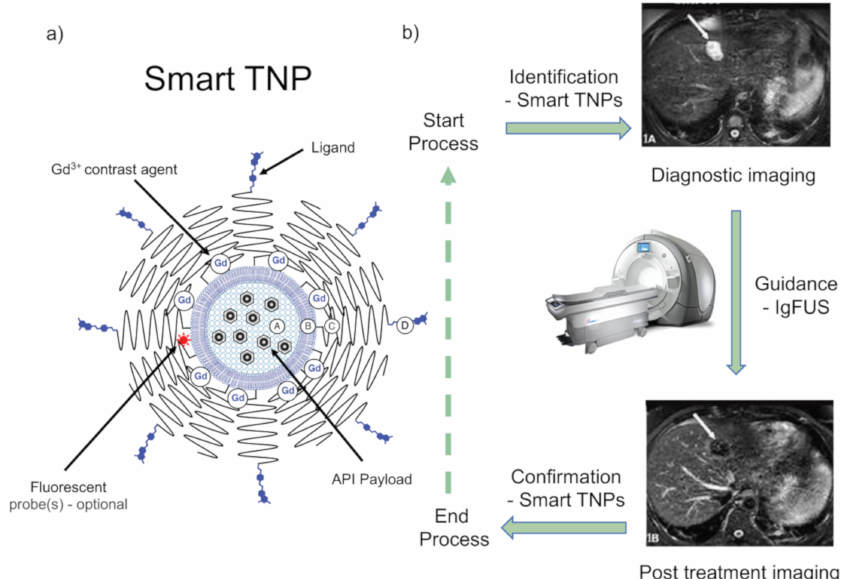
Figure7. SchematicrepresentationofapossiblePTAforthetreatmentofCHBinpatients. ( a )Aschematic representation of a theranostic lipid-based nanoparticle (smart TNP) that is enabled for the targeted delivery of an appropriate therapeutic API. According to this paradigm, a smart TNP, as shown, comprises a therapeutic API payload for delivery (A) that is encapsulated within concentric layers of lipids (B) and a layer of stealth-biocompatibility polymer (C) (typically polyethylene glycol), then capped withoptionalbiologicalcellreceptor-specifictargetingligands(D)onitssurface. Forreal-time / diagnostic imaging purposes, a given API should be co-delivered with either a near-infrared fluorophore and / or an MRI contrast agent such as chelated-Gd 3 + ions—which act as a positive contrast agent in images of body sections generated by MRI. ( b ) Any PTA for CHB treatment implies a three-stage process; (1) identification of diseased areas of the liver using a clinically appropriate advanced imaging technique, such as MRI, in conjunction with targeted imaging agents (including imaging lipid nanoparticles [LNPs], or smart TNPs, as above) to show precisely where priority HBV infections of hepatocytes are found; (2) guidance of smart TNPs to high priority HBV infection areas by means of image-guided focused ultrasound (IgFUS) typically aided by MRI; (3) confirmation of e ff ects of targeted API delivery on the zones of CHB infection in the liver by long-term follow up using a clinically appropriate advanced imaging technique, such as MRI. In this instance, smart TNPs will label up disease target areas for as long as infected cells or intracellular infection exists. The schematic anticipates that there may be more than one round of treatment as